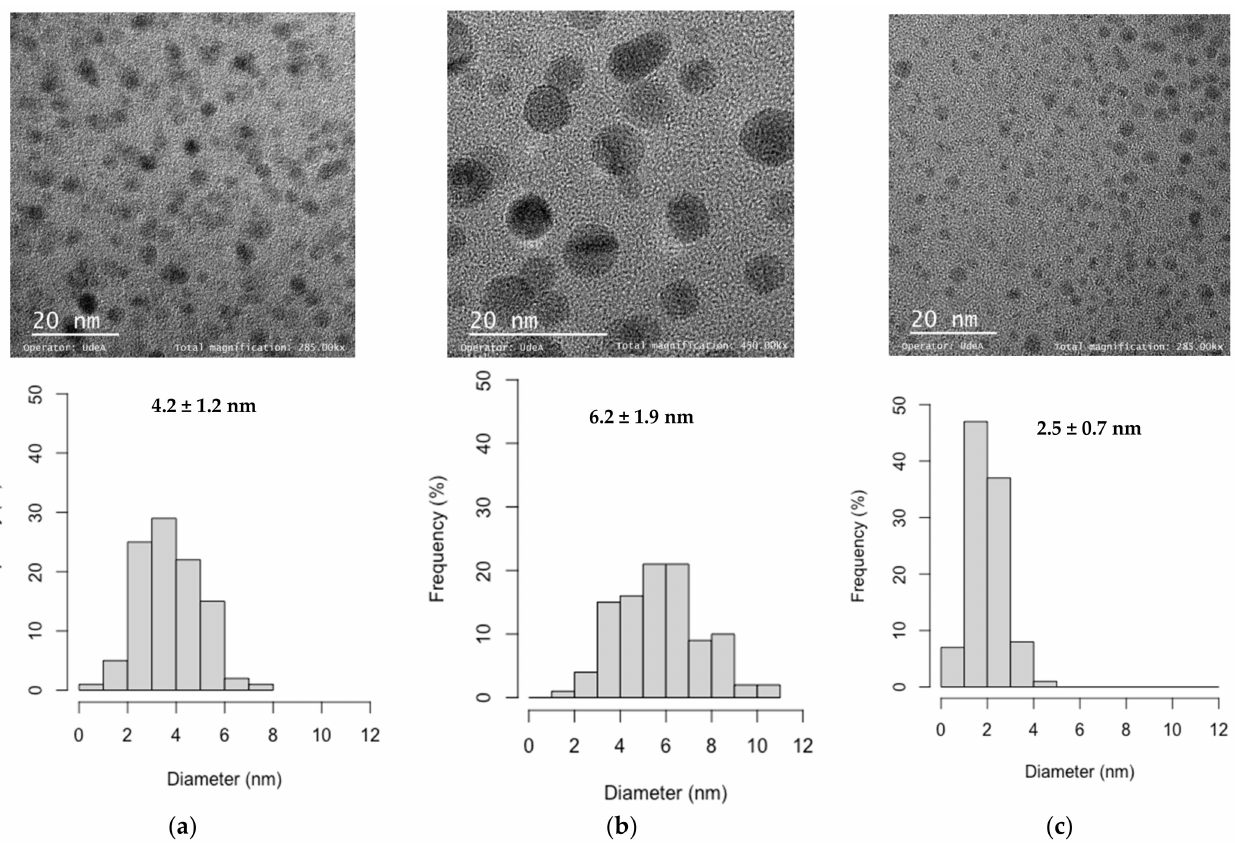
Figure 3. TEM images of ( a ) Picea , ( b ) Molinia caerulea and ( c ) Elaeis guineensis . Histogram of particle diameter distribution of C-Dots